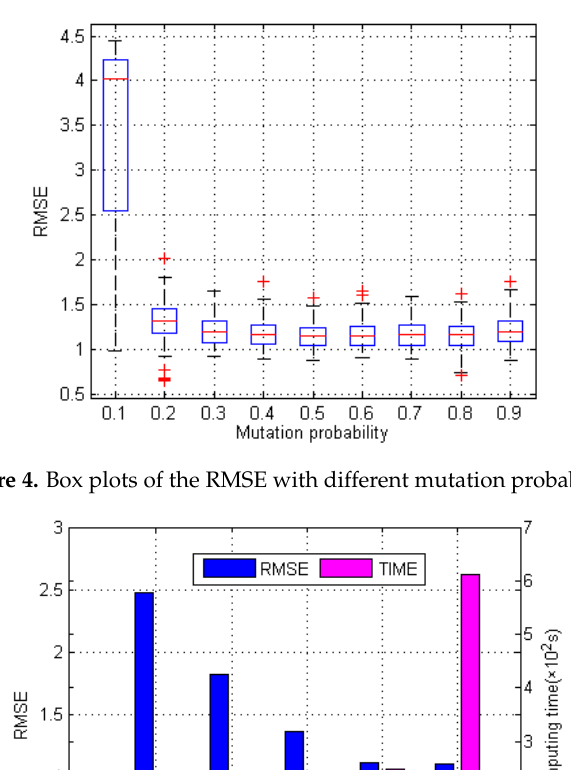
Figure 3. Box plots of the RMSE with different crossover probability.